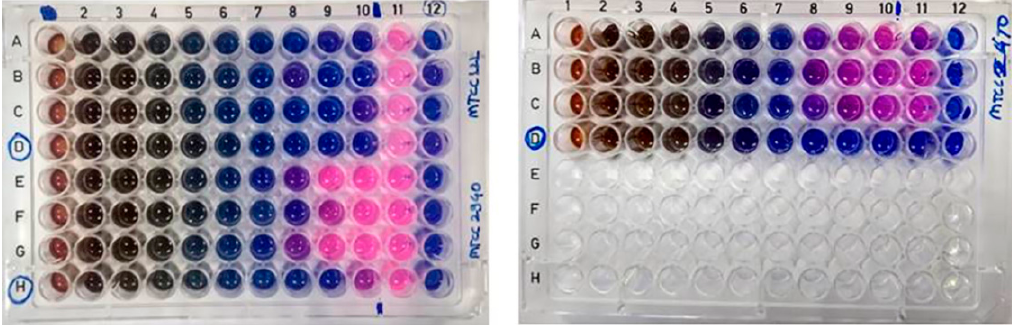
Figure 11. Microtitre plate showing MIC of crude pigment of G. triuniae NFCCI 4873. The MBC of the crude hexane extract of G. triuniae NFCCI 4873 was found to be 1 mg/mL against B. subtilis MTCC 121 and>1 mg/mL against S. aureus MLS 16 MTCC 2940; whereas it was 0.25 mg/mL against M. luteus MTCC